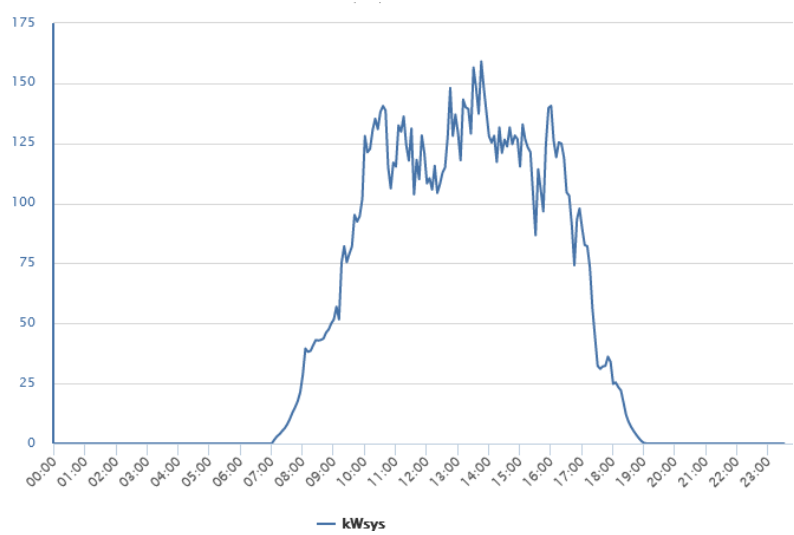
Figure 2. Typical hospital load curve.